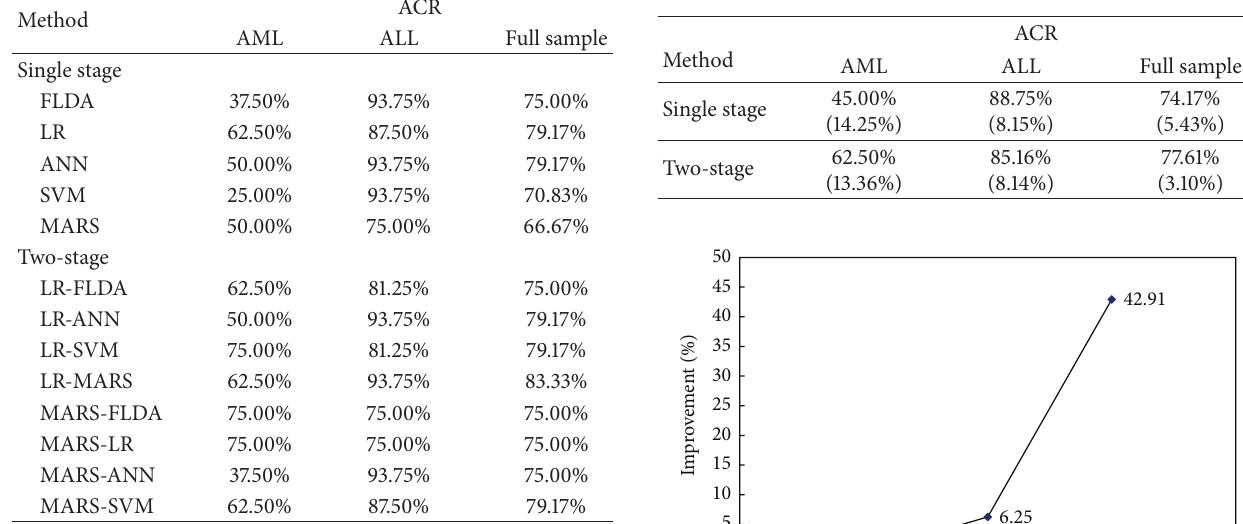
Table 4: ACRs for thirteen approaches using cross-validation. Table 5: Overall averaged ACR and the associated standard error (in parentheses) for single stage and two-stage methods.